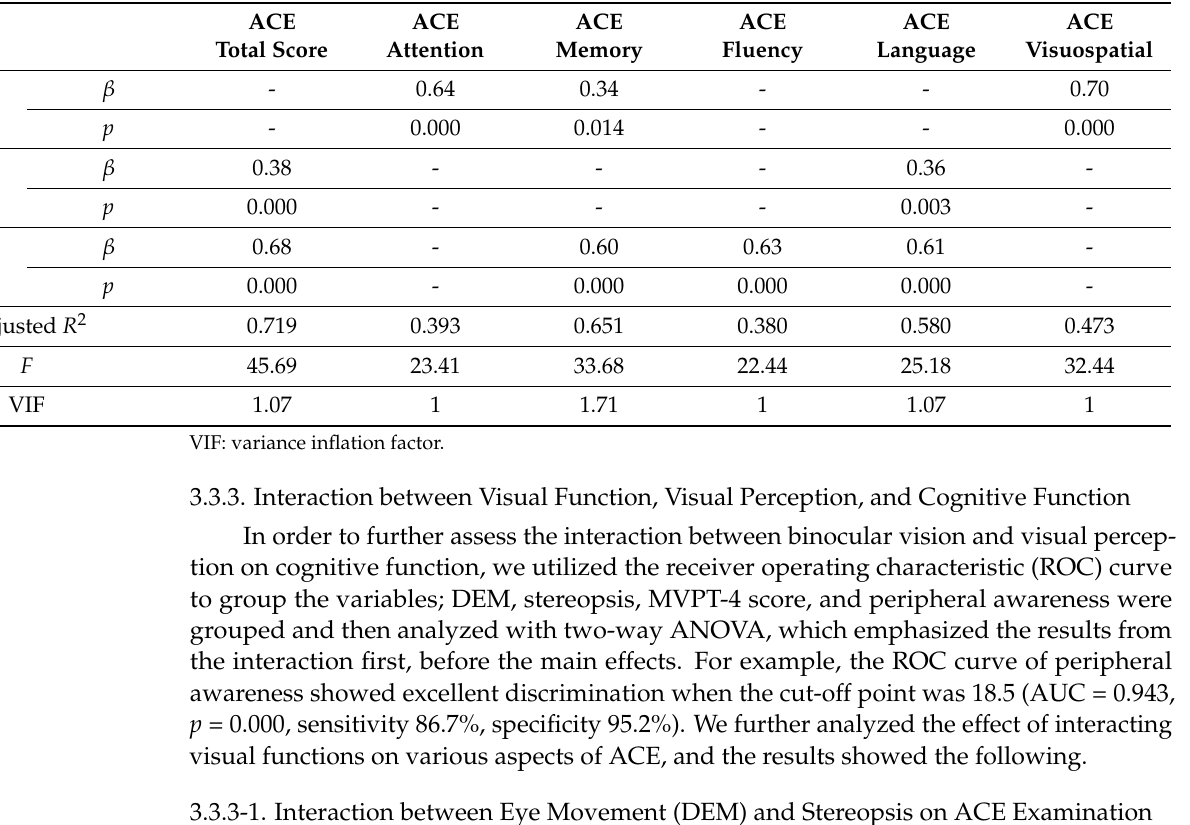
Table 5. Linear regression analysis (Forward) of visual perception and cognitive